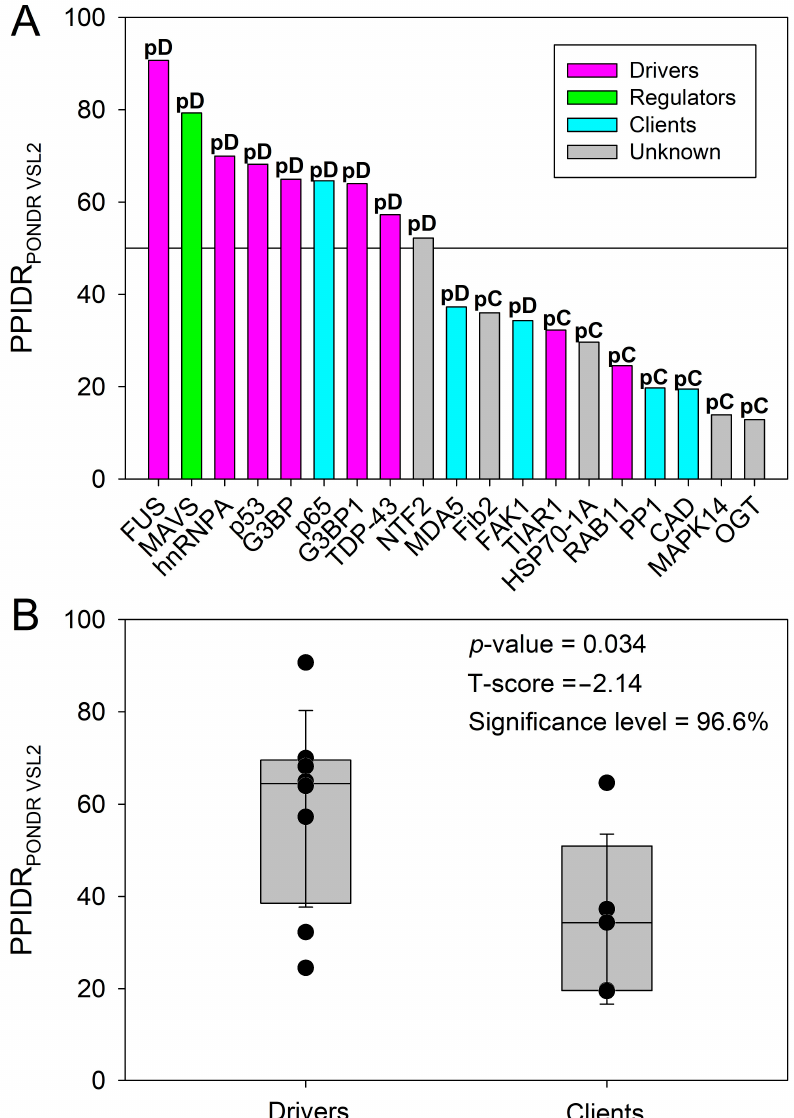
Figure 7. ( A ) Correlations between protein intrinsic disorder content, PPIDR PONDR VSL2 , evaluated by PONDR ® VSL2, and the experimentally validated role in LLPS for each of the 19 proteins in our data set, as retrieved by browsing MLOsMetaDB (https://mlos.leloir.org.ar, accessed on 4 January 2023). The continuous horizontal line corresponds to a 50% content in disorder. Proteins predicted as drivers or as clients by FuzDrop (see Table 1) are marked as pD and pC , respectively. ( B ) Statistical analysis based on Student’s t -test. Note that both Normality and Equal Variance tests were successfully passed, indicating the suitability of the t -test to assess statistically significant differences. The analysis was conducted using the online Georgiev G.Z., “P-value Calculator” (https://www.gigacalculator.com/calculators/p-value-significance-calculator.php URL, accessed on 5 January 2023).